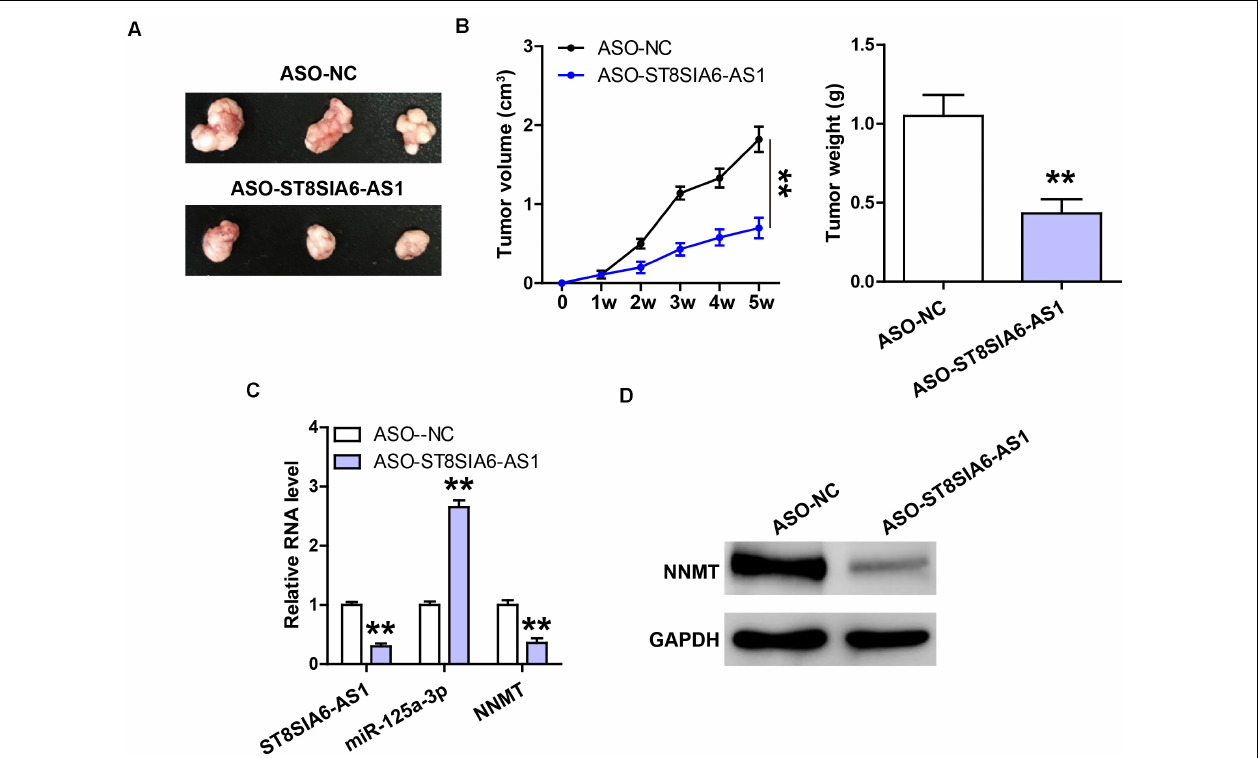
FIGURE 6 | Knockdown of ST8SIA6-AS1 inhibits tumor growth. (A,B) Tumor volume and weight of nude mice bearing control or ST8SIA6-AS1-silenced NCI-H23 cells. (C) qRT-PCR analysis of ST8SIA6-AS1, miR-125a-3p, and NNMT expression in control or ST8SIA6-AS1-silenced tumor tissues. (D) Western blot testing NNMT protein level in control or ST8SIA6-AS1-silenced tumor tissues. ** P <